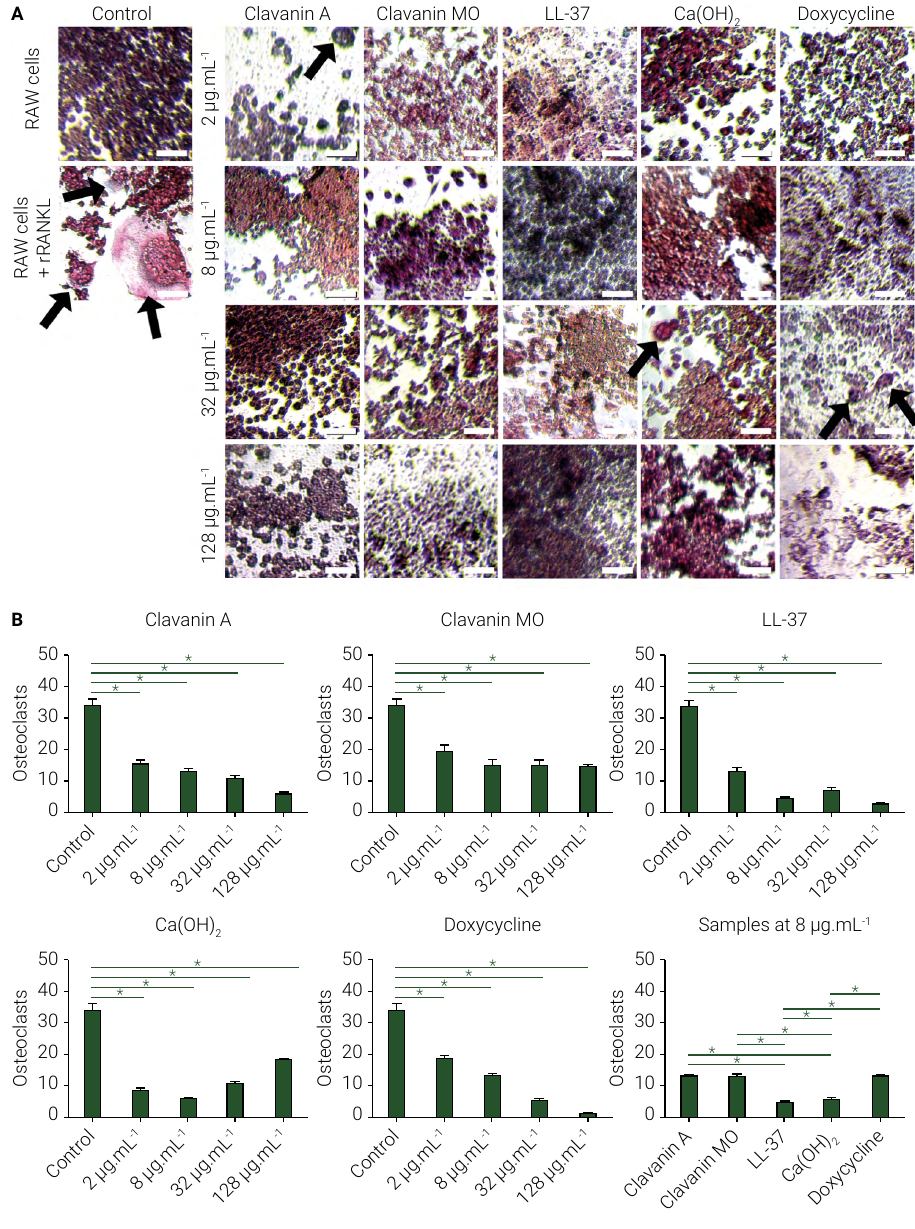
Figure 3. Representative photos of TRAP positive stained cells (A) and number of multinucleated osteoclast- like cells (B) induced by 2.5x10 3 RAW cell and 2.5x10 3 RAW cells stimulated with 100 ng.mL -1 rRANKL (Control). Cultures were rRANKL-stimulated and tested with 2, 8, 32, and 128 μg.mL -1 of clavanin A, clavanin MO, LL-37, Ca(OH) and doxycycline, after 7 days. Scale bar: 50 μM. Each well was completely checked, 2 and osteoclasts were counted at 20x magnification. Black arrows show osteoclast-like cells with more than 3 nuclei. Statistical differences by one-way ANOVA test and Tukey’s post hoc were represented by *p<0.001 compared to control in each tested condition. Statistical differences of comparative analysis of the lowest common concentration, with greater reduction in osteoclast-like cell differentiation, of all tested materials: 8μg.mL -1 of clavanin A, clavanin MO, LL-37, Ca(OH) and doxycycline (samples at 8μg.mL -1 ) were 2 represented by *p<0.0001. Number of osteoclast-like cells was represented as the standard error of the mean. All experiments were done in technical and biological